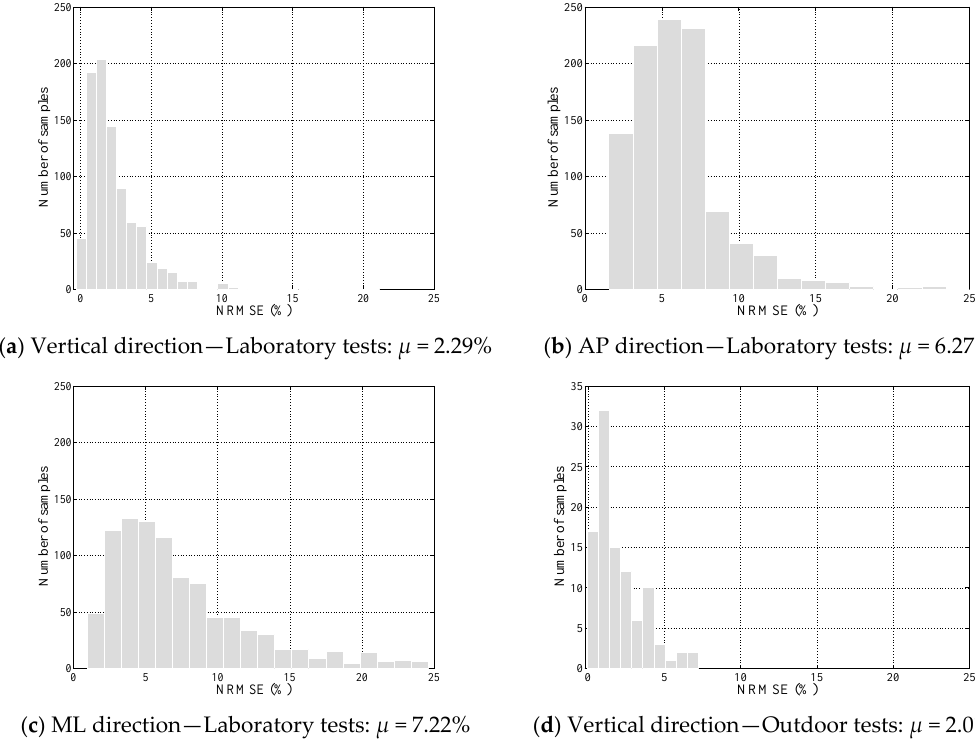
Figure 8. Performance of TPM in the laboratory and outdoor environment.